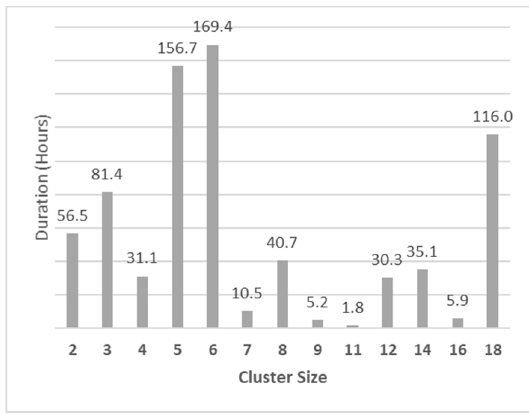
Figure 4. Average cluster duration by cluster size (2013–2019).